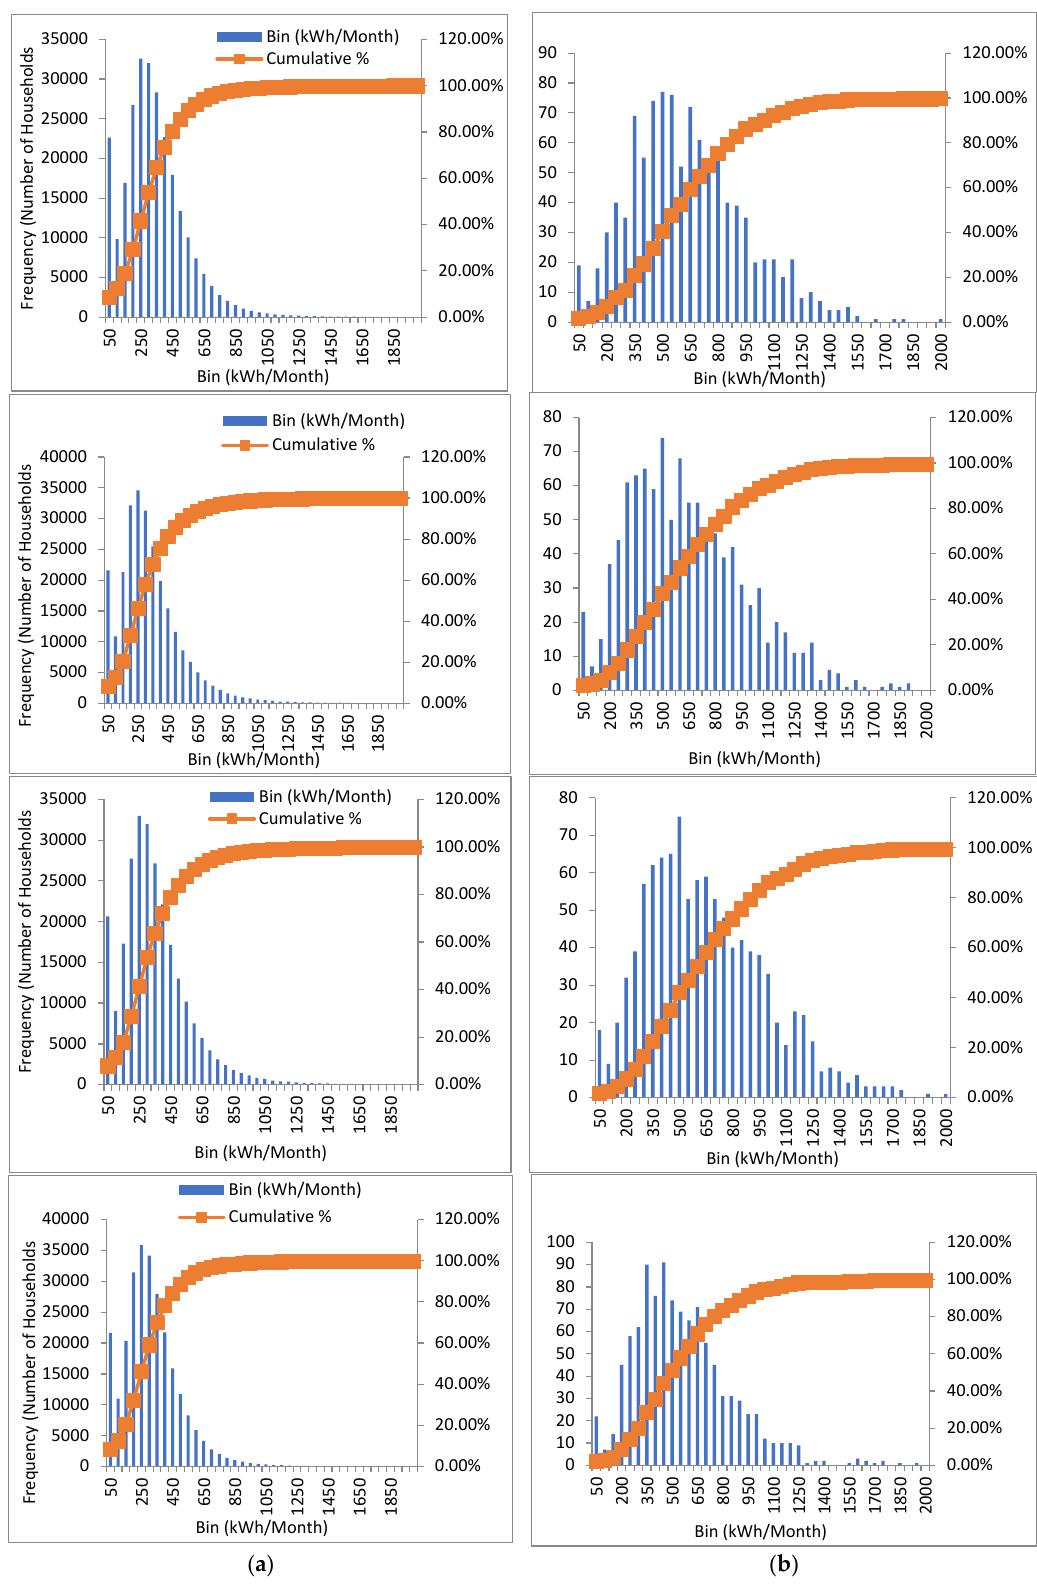
Figure 10. Energy consumption June, July, August, and September: ( a ) Ordinary households; and ( b ) Subsidized